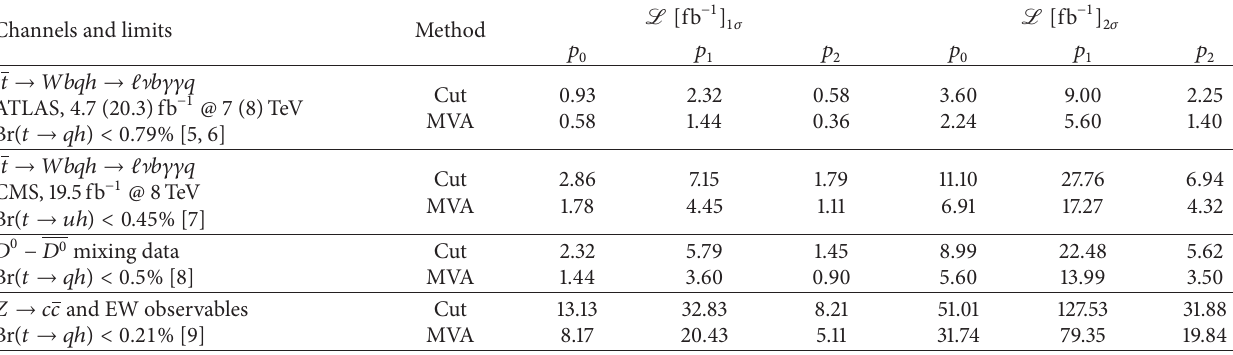
Table 4: The integrated luminosity ( L ) needed to get the upper bounds on Br (𝑡 → 𝑞ℎ) at 95 % CL obtained from the experiments. Both the cut- (MVA-) based results and 1 𝜎 (2 𝜎 ) limits with 𝑒 -beam polarization are presented. Channels and limits